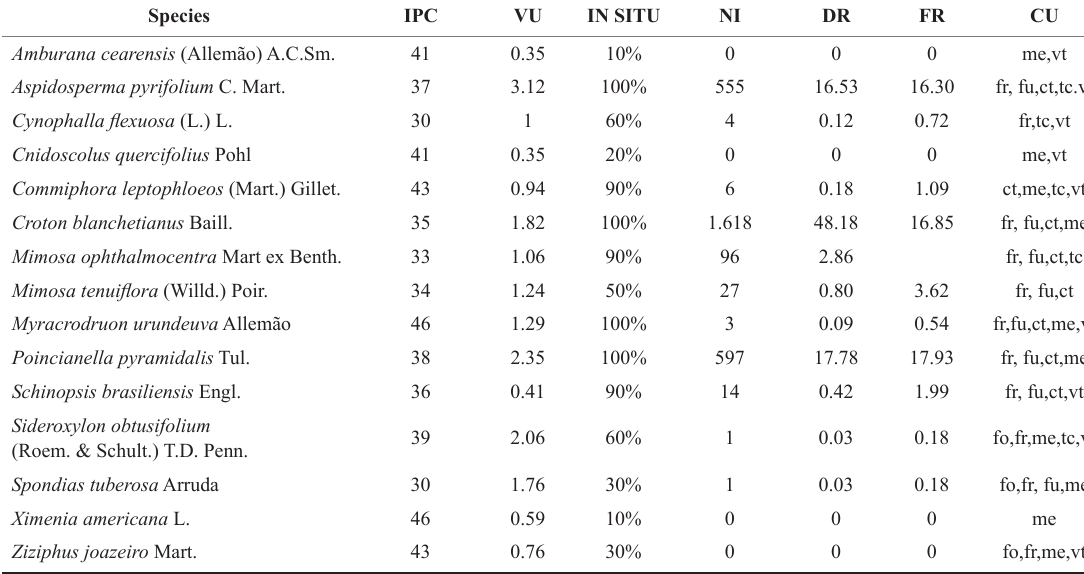
Values of second greater important species use value (VU), the inventory in situ and conservation priority index (IPC) in the community of Barrocas, the municipality of Soledade, Paraiba, Brazil. Where: IPC = index of conservation priority, VU = use value; IN SITU = percentage of species in inventory situ; NI = number of individuals registered in phytosociology; RD = relative density, RF = relative frequency; CU = categories use. In the categories of use we